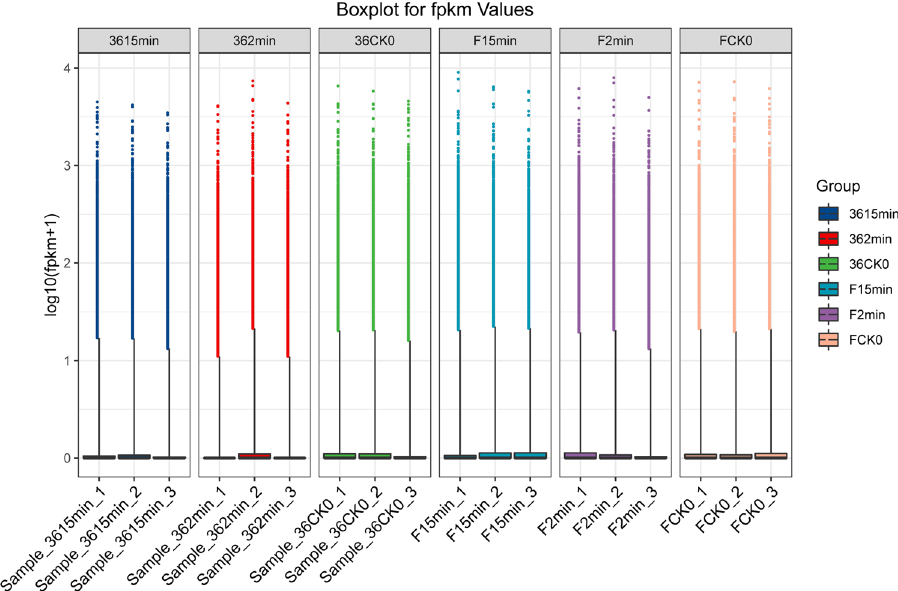
Figure 2. Distribution of gene expression levels in each sample. FPKM, fragments per kb per